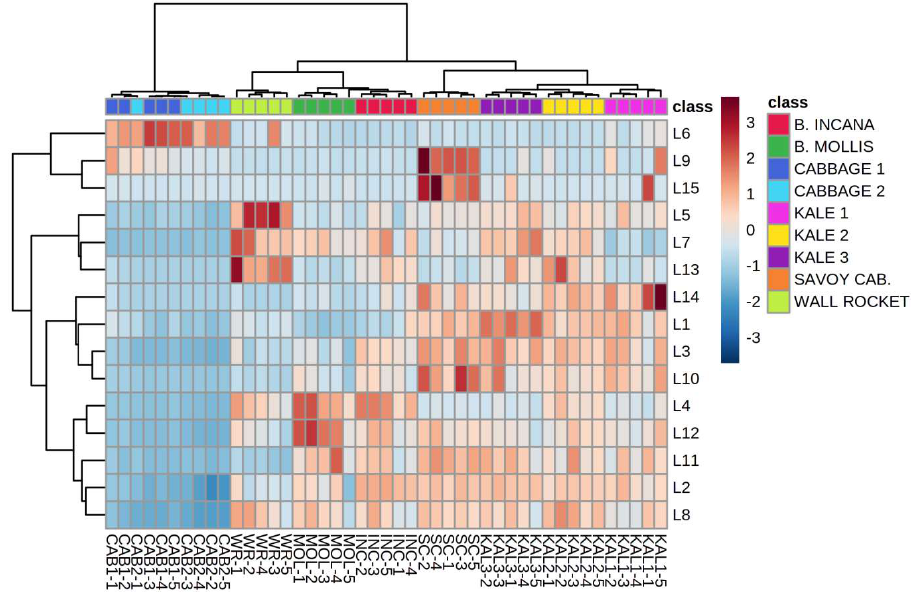
Figure 1. Clustering of Brassicaceae species by hierarchical cluster analysis (HCA) based on the composition of volatile compounds generated in the lipoxygenase (LOX) pathway. The rows in the heatmap diagram represent compounds and the columns represent samples. Codes indicating compounds correspond to those reported in Table 1. Colors of the heatmap cells indicate a low (dark blue), medium (white), and high (dark red) abundance of a particular compound. To better identify volatile compounds characteristic for particular species, which are therefore most useful for their mutual differentiation, the data on volatiles were subjected to partial least squares–discriminant analysis (PLS-DA). Savoy cabbage and wall rocket were excluded from PLS-DA since they were represented by a single variety or accession, respectively, while two cabbage landraces, three kale accessions, and two wild species B. incana and B. mollis were grouped into three corresponding groups, respectively. The PLS-DA differentiation according to species based on LOX volatiles data was very suc- cessful, as can be seen in Figure 2a. Twenty LOX volatile compounds with the highest variable importance in projection (VIP) scores are listed in Figure 2b. A compound with the highest VIP score (>2.0) was trans -2-butenal (L4), which was most abundant in two wild species and least abundant in cabbage. Several other LOX volatile compounds with relatively high VIP scores (>1.4) were confirmed to be most characteristic for wild species, such as trans , trans -2,4-heptadienal (L12), trans -2-hexenal (L20), trans -2-pentenal (L22), 1-penten-3-ol (L2), 6-methyl-5-hepten-2-ol (L7), and 1-penten-3-one (L24). High amounts of 3,4-nonadiene (L11), trans , cis -2,4-heptadienal (L8), and cis -4-heptenal (L16) served for the differentiation of kale, while the main marker for cabbage among LOX compounds was 2-ethyl-1-hexanol (L6).